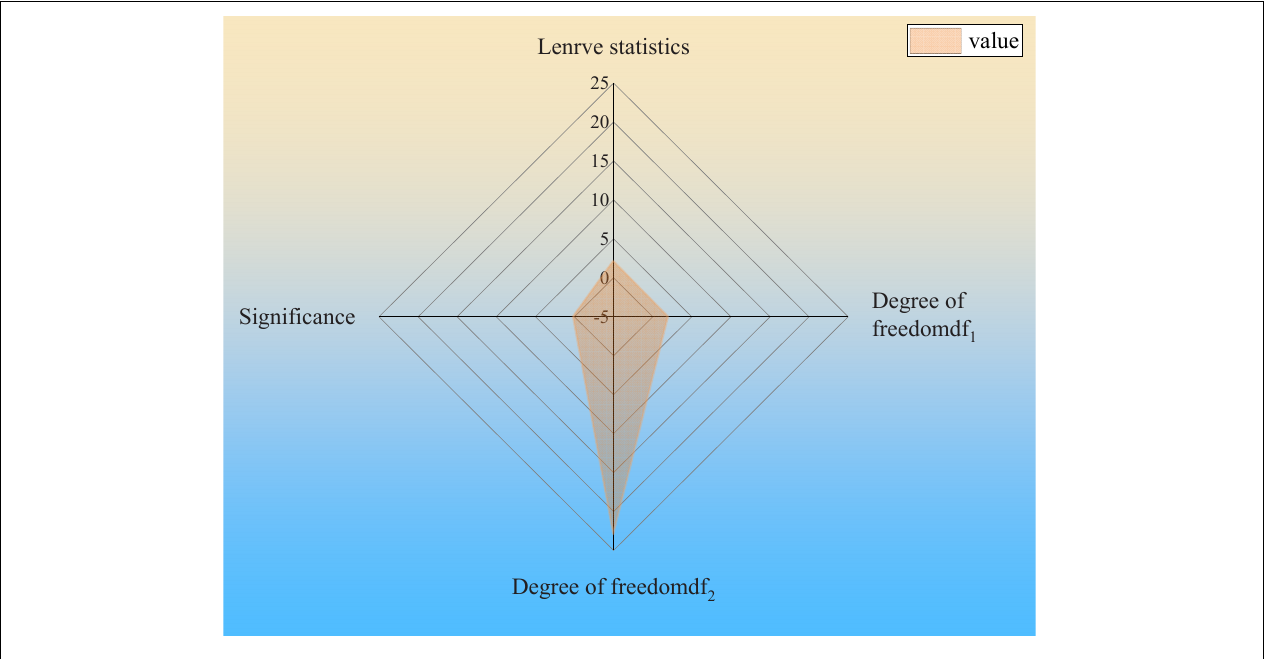
FIGURE 5 | Variance homogeneity